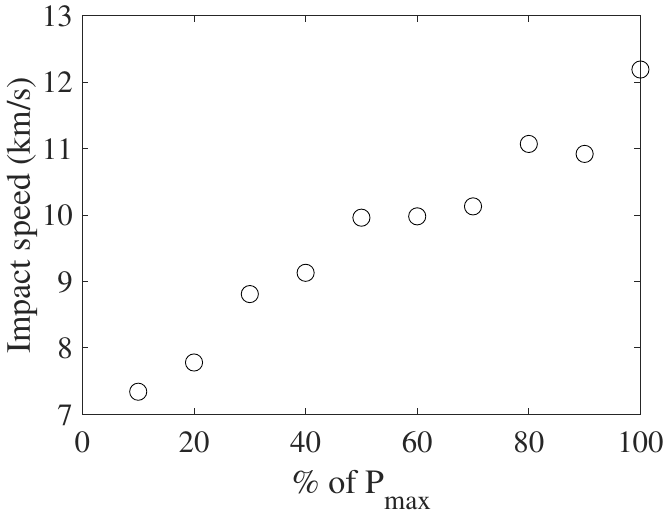
Figure 2. Variation of the impact speed with power as a % of P max ( C 3 = 4.676 km 2 s − 2 , m prop = 150 kg, and Φ =